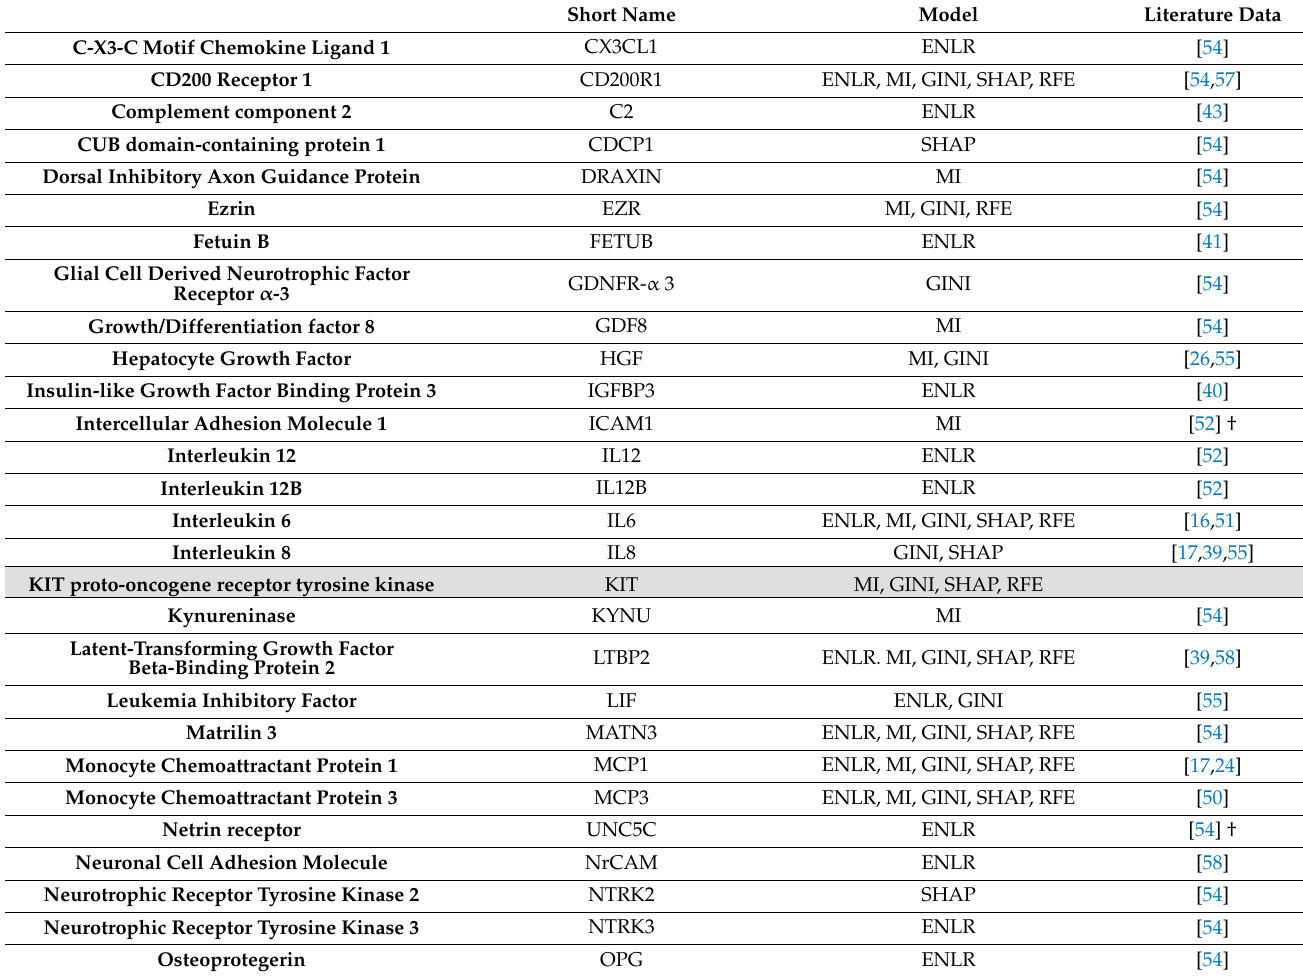
Table 4. Summary of biomarkers emerging from the correlation discovery